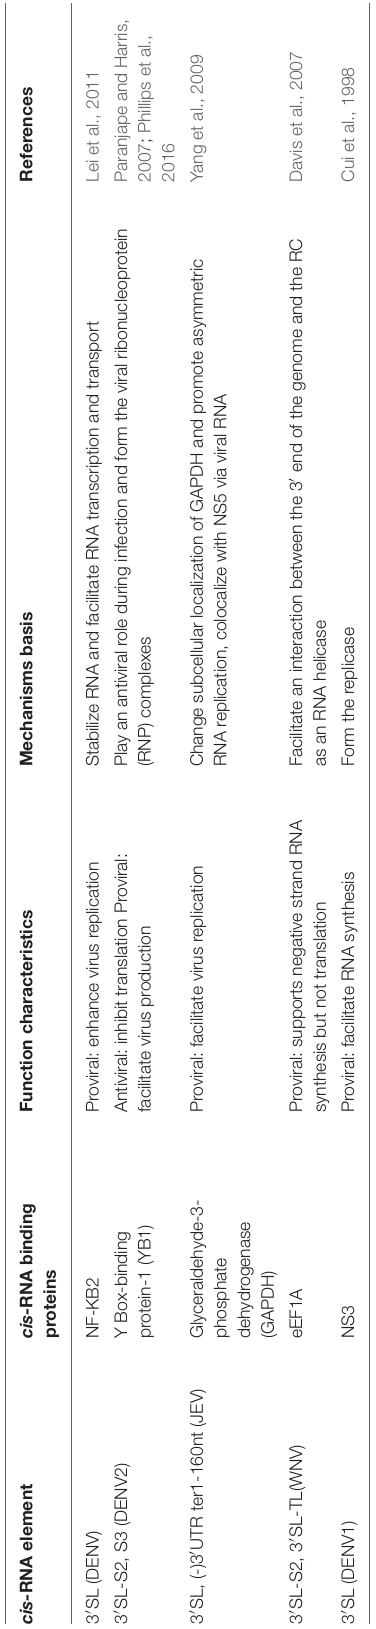
resembles 5 (cid:48) -3 (cid:48) DARII in the dual-DAR MBFVGs ( Figure 2B ). Last but not least, the 5 (cid:48) UAR/3 (cid:48) UAR are strikingly divergent with different quantities and sizes of bulges even in the same 1998 MBFVG ( Figure 2 ). Additionally, the internal unmatched base-pairings in 5 (cid:48) UAR/3 (cid:48) UAR are less conserved in 5 (cid:48) -3 (cid:48) cirRNA and tend to participate in the local secondary structure in